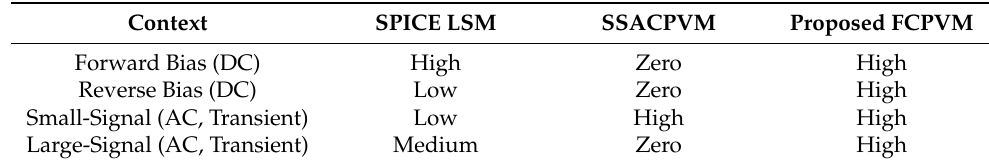
Table 4. Summarising the suitability of the examined SPICE-compatible circuit PV models within different